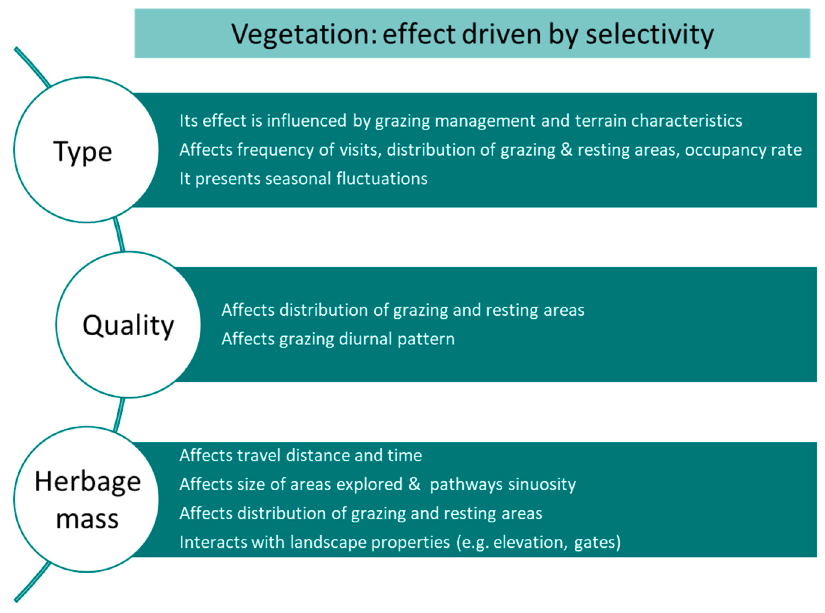
Figure 11. Main characteristics of the effect of vegetation on the distribution of cattle in the